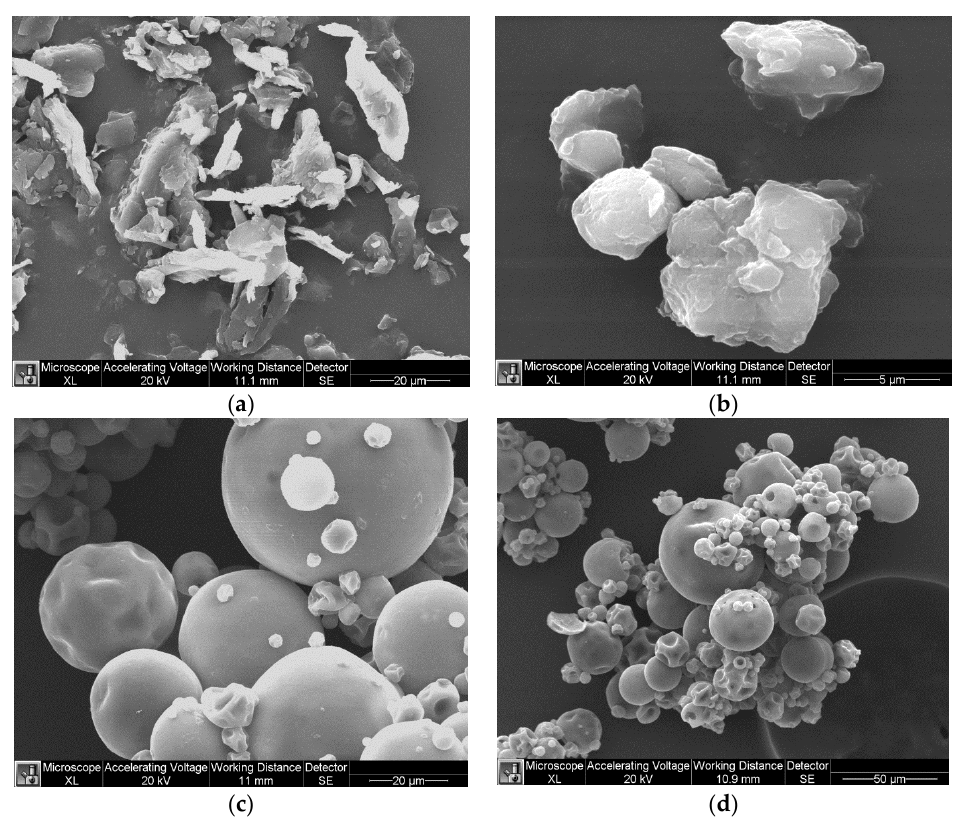
Figure 3. Thermogravimetric analysis of CNC and CNC Surfactant.